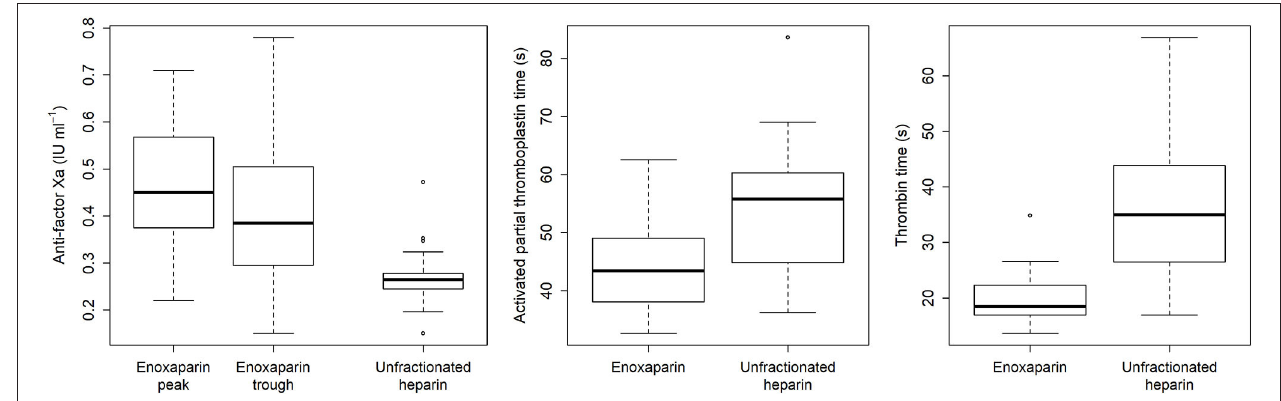
FIGURE 3 | Laboratory parameters used to monitor the anticoagulant medications during extracorporeal membrane